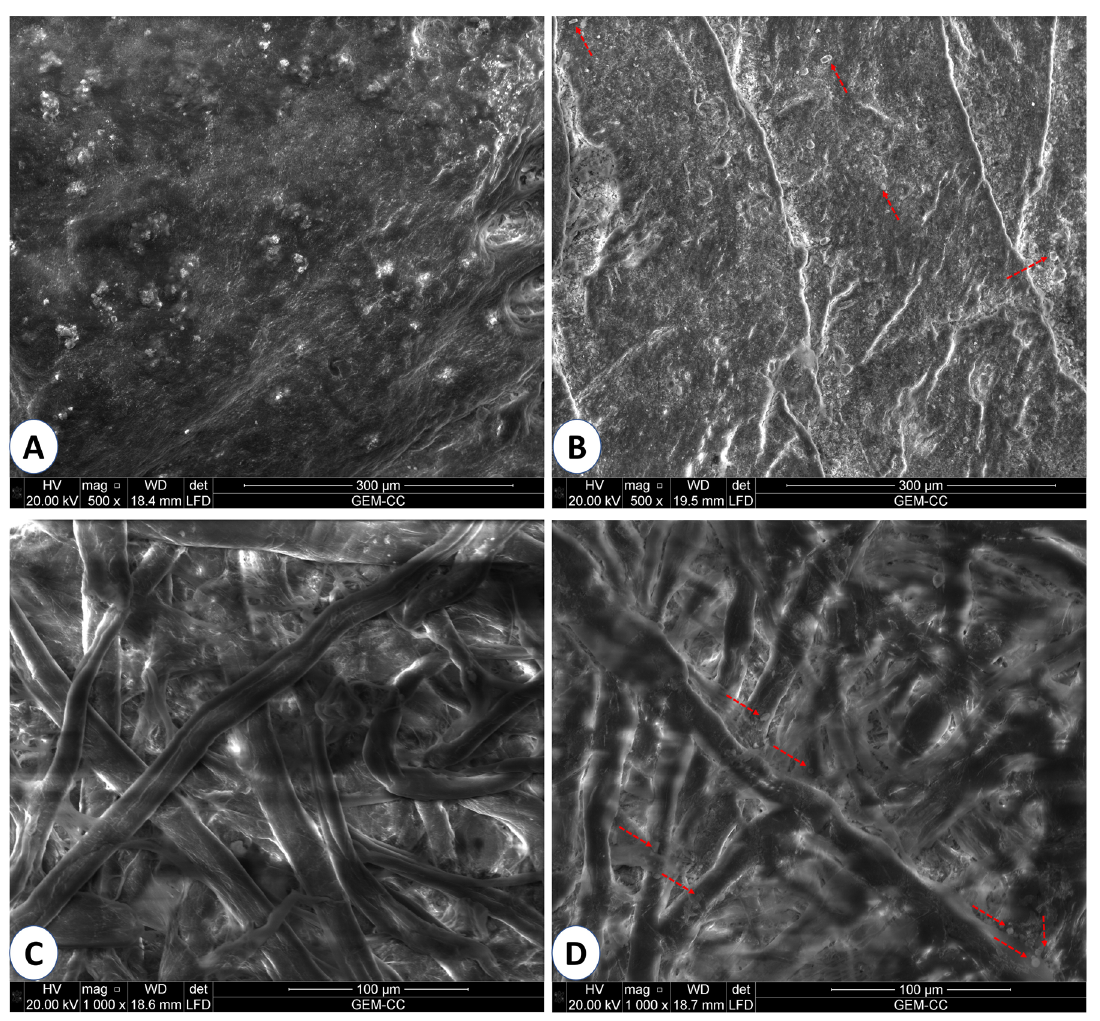
Fig. 2 SEM for historical leather binding and papers compared with control samples. A Is a leather sample (control), B is the historical leather, C is Whatman No. 1 (control), and D is the historical paper. The arrows refer to microbial